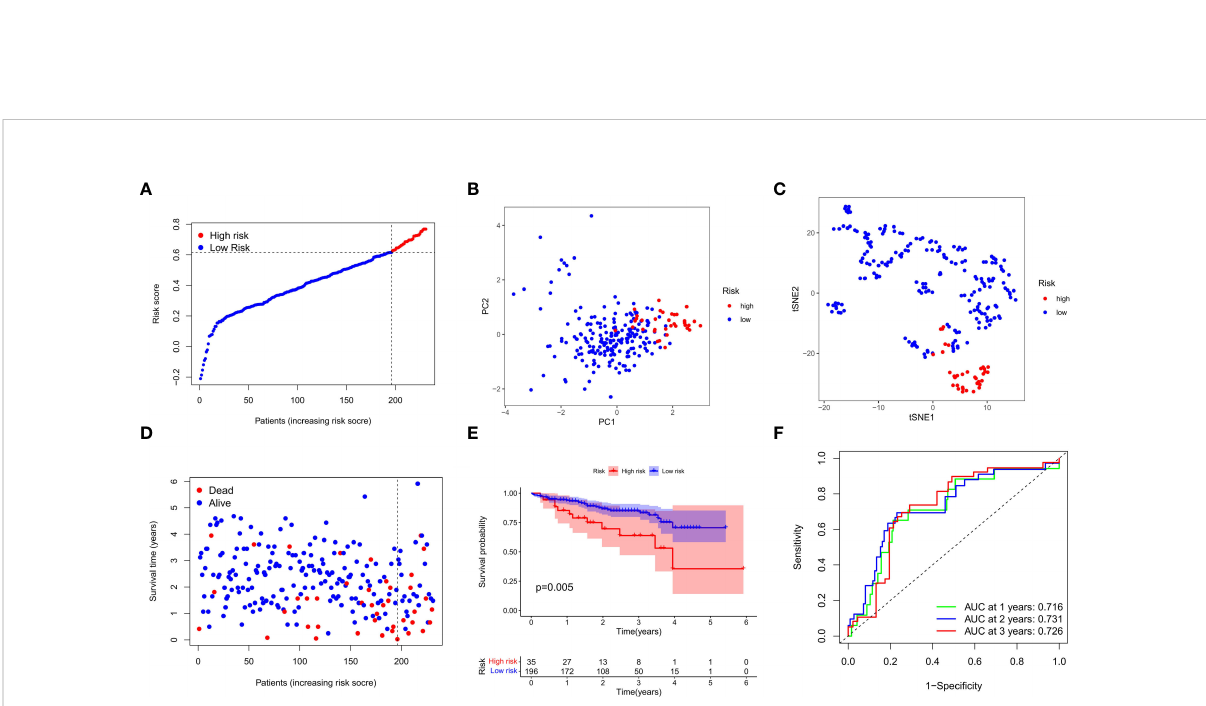
FIGURE 5 External validation of the prognostic model in the ICGC cohort. (A) Distribution of the risk scores in the ICGC cohort. (B) The PCA analysis for survival status of HCC patients in the ICGC cohort. (C) T-SNE analysis was conducted for survival status of HCC patients in the ICGC cohort. (D) The survival status for each patient was displayed in the high- and low-risk groups. (E) Kaplan-Meier survival curves between low- and high-risk groups were shown. (F) ROC curves were assessed for survival status corresponding to 1, 2, and 3 years